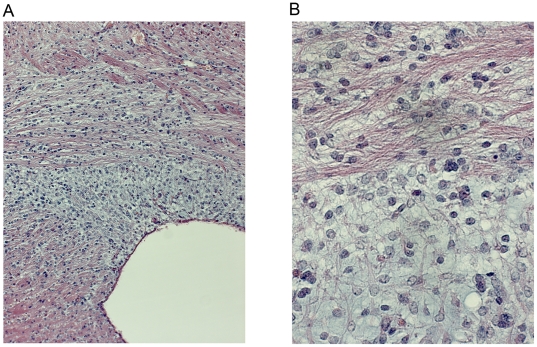
Morphology of accumulating cells in the PDGF-AL brain.Light microscopy images of an H&E stained section, in low (A) and high (B) magnification, illustrating the presence of immature cells in the roof of the lateral ventricle in a PDGF-AL transgenice mouse brain (AL8 line, #4012).